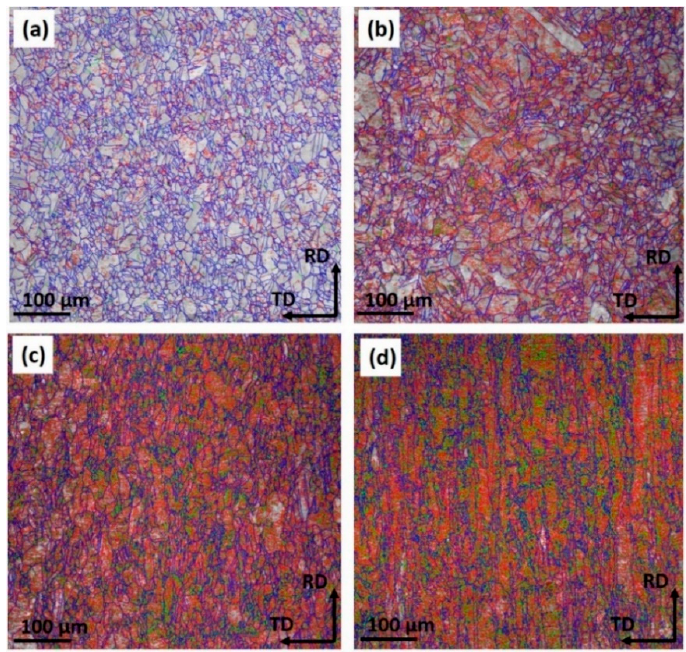
Figure 9. EBSD mapping of microstructures for Cu strips under different cold rolling reductions after being corroded by O/W emulsions. ( a ) 0% reduction, ( b ) 22.7% reduction, ( c ) 58.6% reduction, and ( d ) 77.3% reduction (in the EBSD mappings, red, green, and blue lines represent the angle of 2–5°, 5–15°, and 15–180° boundaries, respectively.). Table 7. Statistical data of the grain size and grain boundary variations.